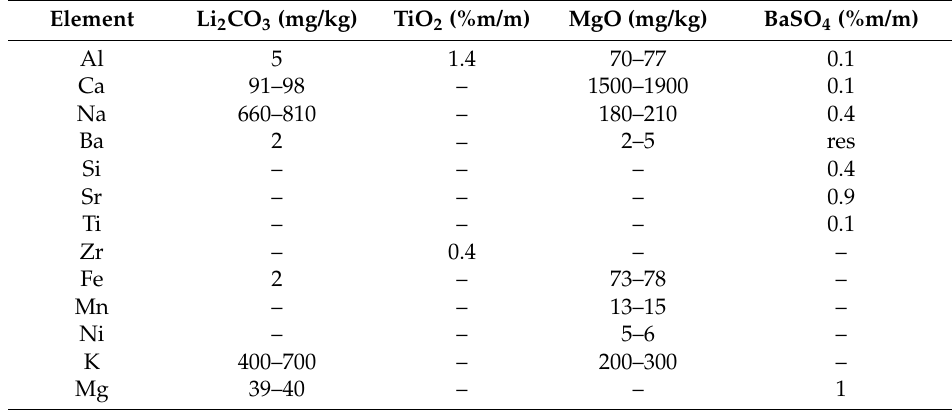
Table 1. Chemical composition of inorganic additives used in this